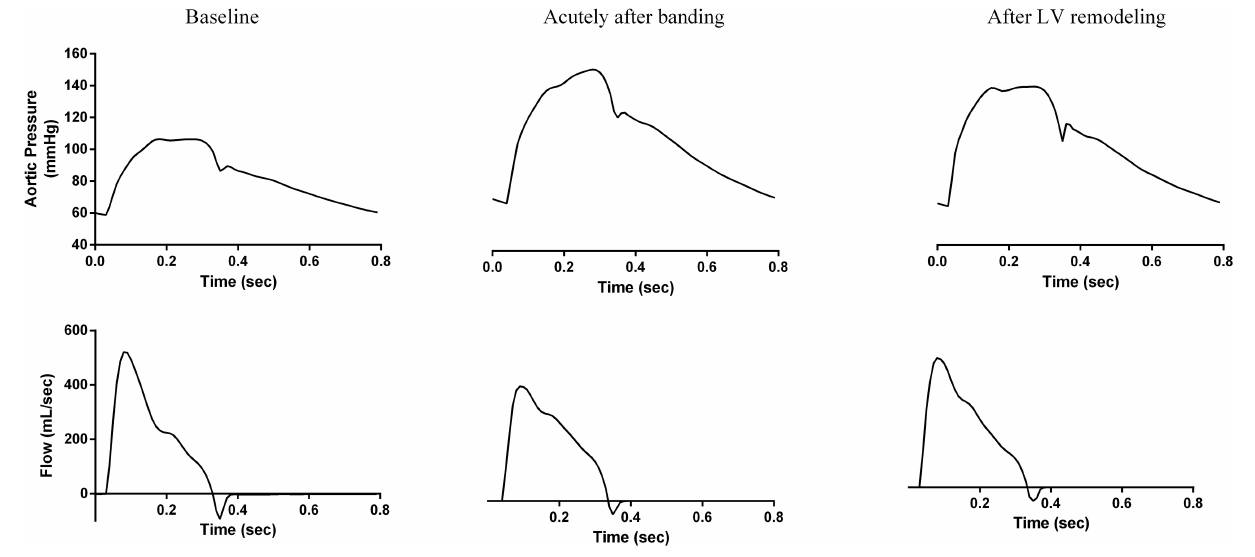
FIGURE 4 | The simulation-generated aortic pressure and flow waves for the three hemodynamic states. (left) Baseline, ( center ) acutely after banding, and (right) after LV